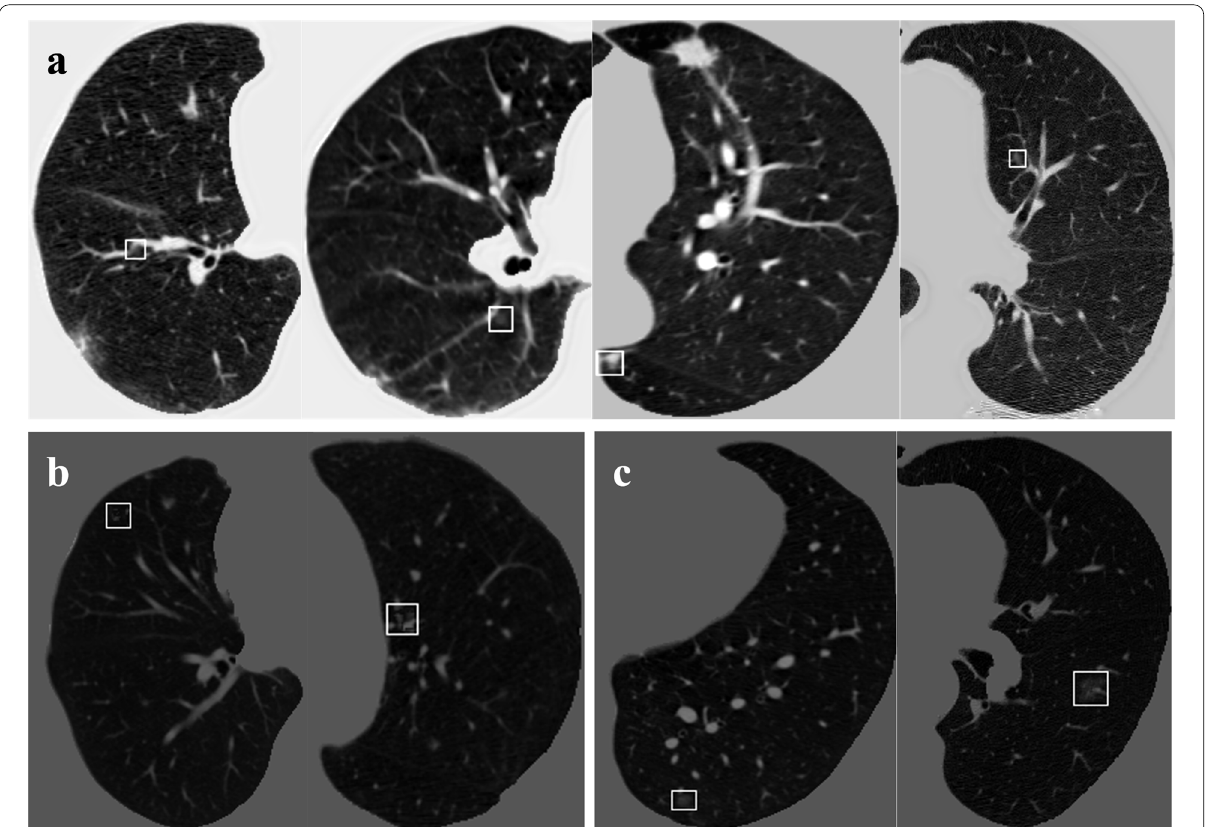
Fig. 3 Examples of synthetic ground glass nodules (GGNs), the GGNs were categorised by physicians to four categories: confidently fake, leaning fake, leaning real, and confidently real. a Synthetic GGNs classified as “real” by clinicians. b Synthetic GGNs with less convincing generated lesions (classified as “leaning fake”). c A real GGNs in the original LIDC-IDRI